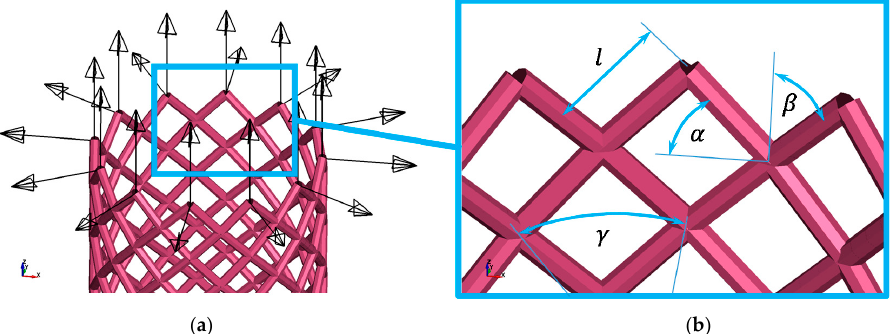
Figure 9. Geometry model of everting structure: upper tube end with Cartesian coordinate systems for definition of cylindrical loads ( a ) and detailed view with dependent geometric variables ( b ). The angle γ between two horizontally neighboring crossing points describes the section angle with center of angle (not shown) that lies on the inner cylinder axis.